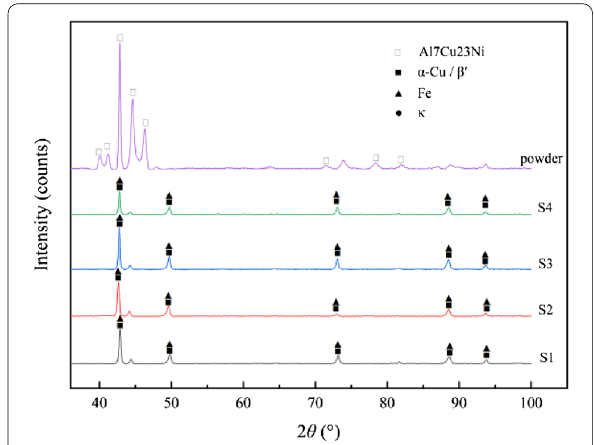
Figure 3 XRD patterns of laser depositing coatings